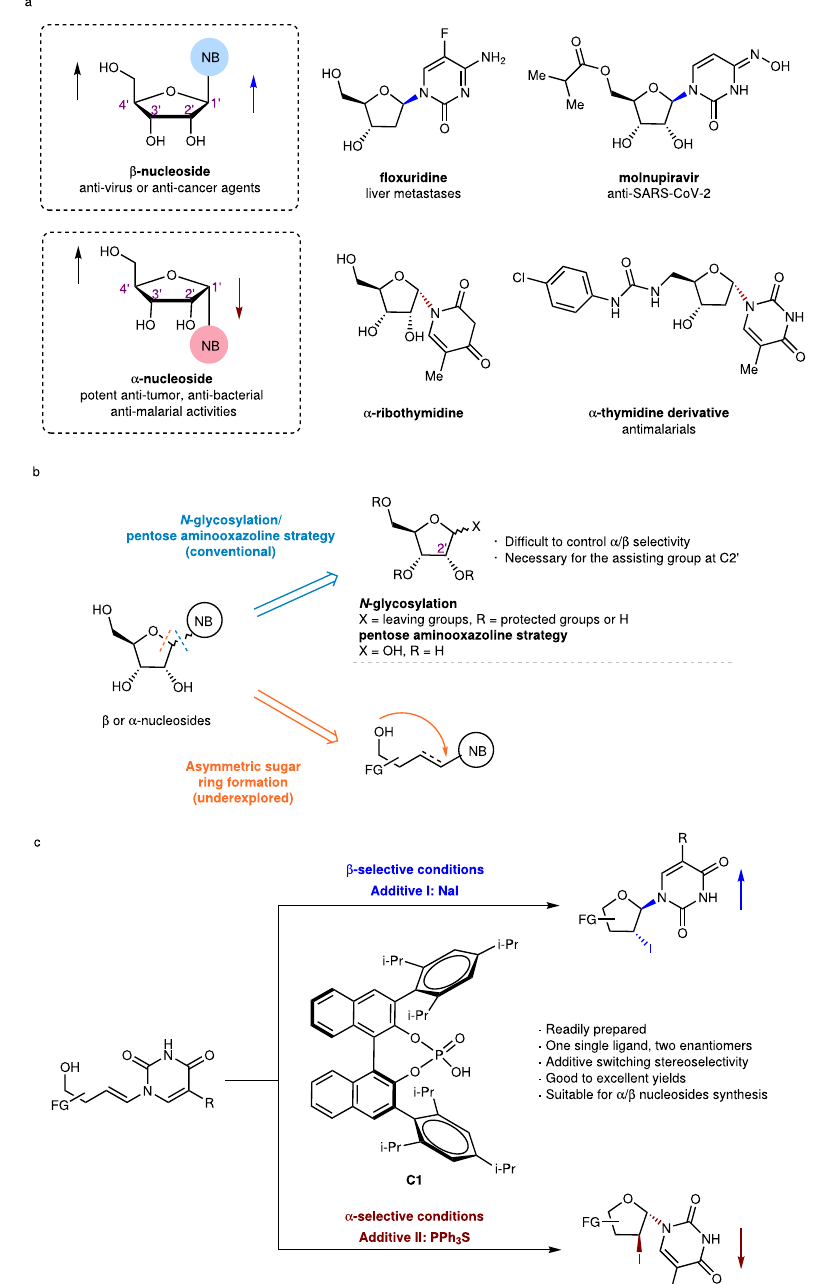
Fig.1|Importanceofnucleosidesandapproachestosynthesizenucleosides.a Signi fi canceof β -nucleosidesand α -nucleosides. b Strategiestoconstructnucleosides. c Additive-controlled iodocyclization for synthesizing α - and β -nucleosides as two optically pure molecules (this